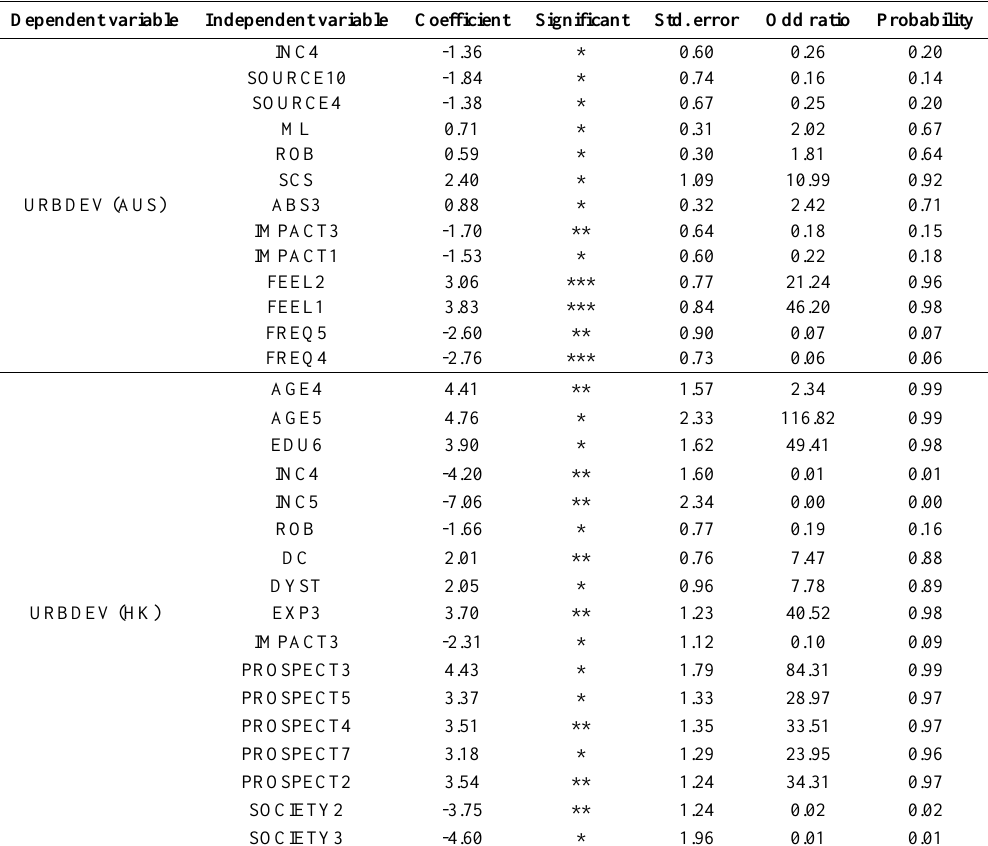
Table A-17. Urban development control and